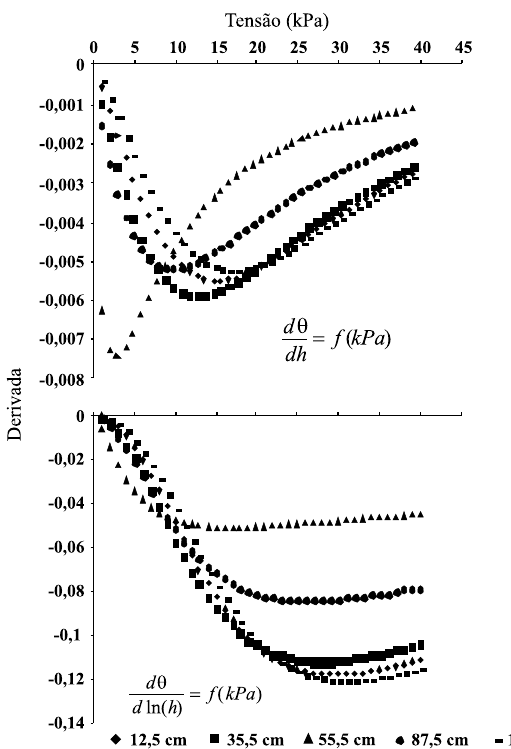
Figura 1. Valores da derivada da equação 1 sem ou com a transformação ln(h) para diferentes profundidades do